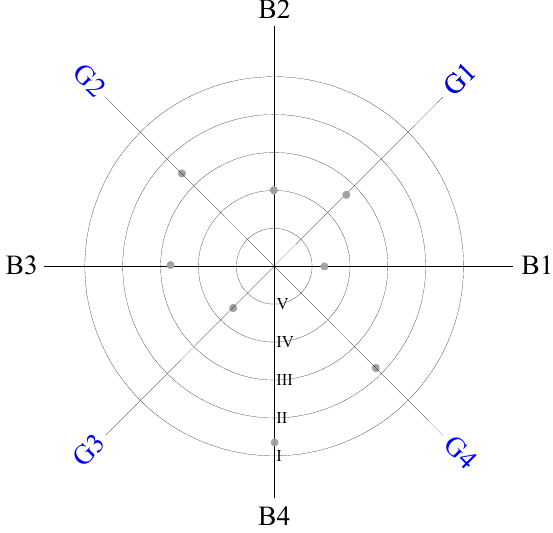
Figure 3. Energy layer diagram of accident-inducing immunity factor.